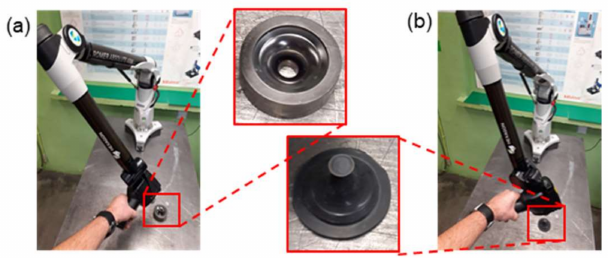
Figure 4. Test stand with a measuring arm ROMER AbsoluteArm 7520si integrated with a linear scanner RS3 for the measurements of: ( a ) tools, ( b ) replicas.